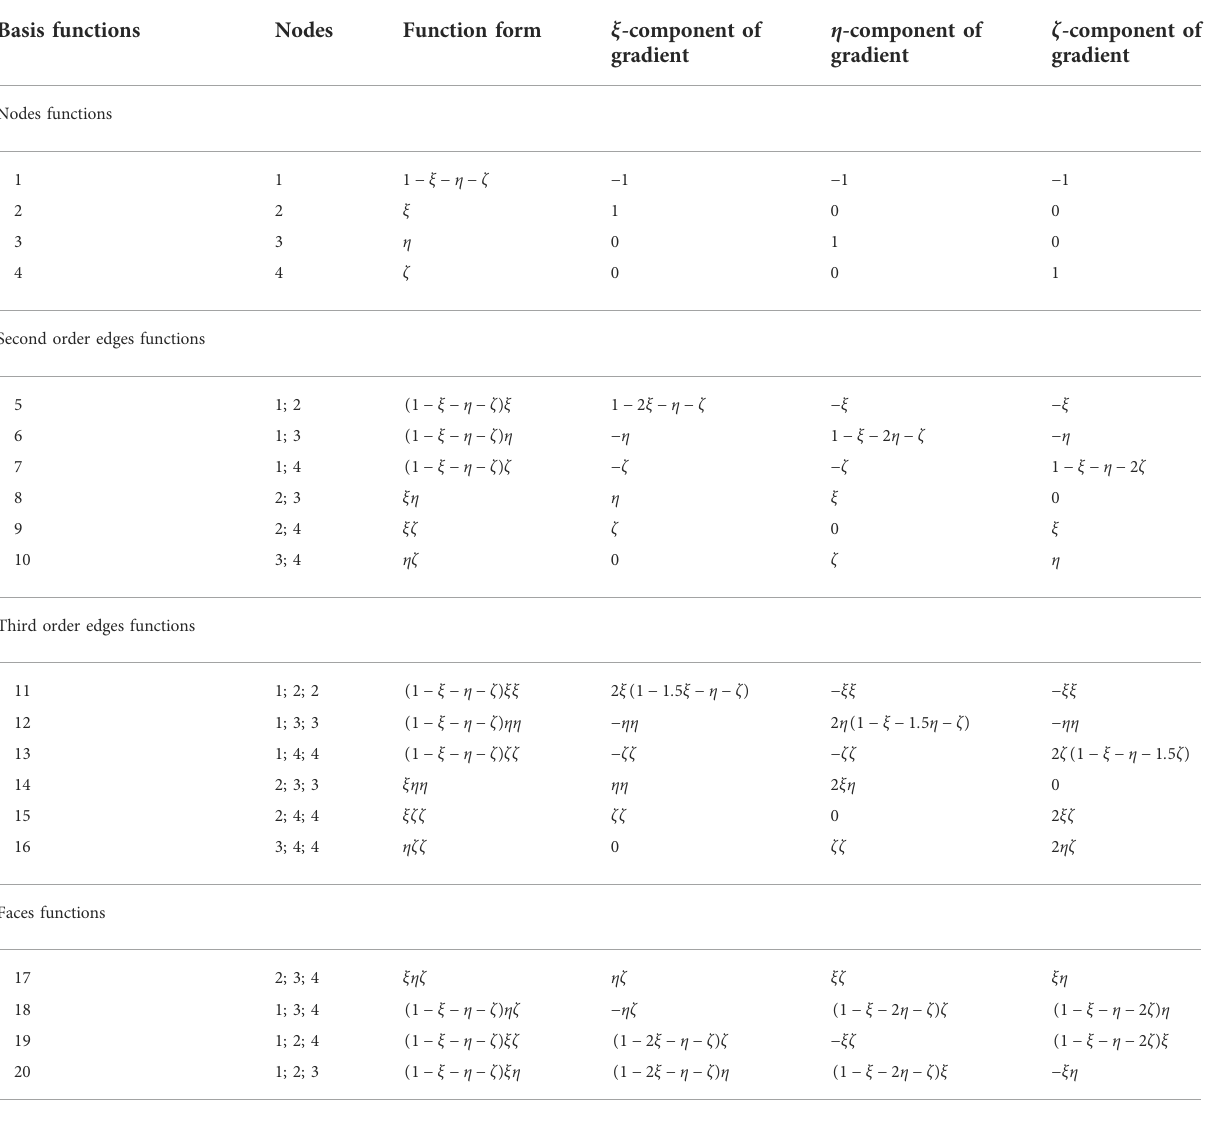
TABLE 2 Hierarchical basis functions and their gradient operation in reference